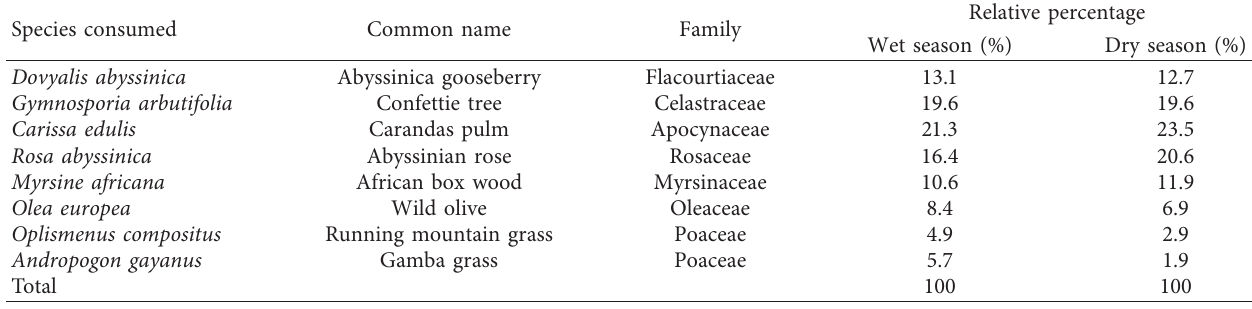
Table 1: Seasonal percentage contribution of plant species consumed by klipspringers during the dry and wet seasons.